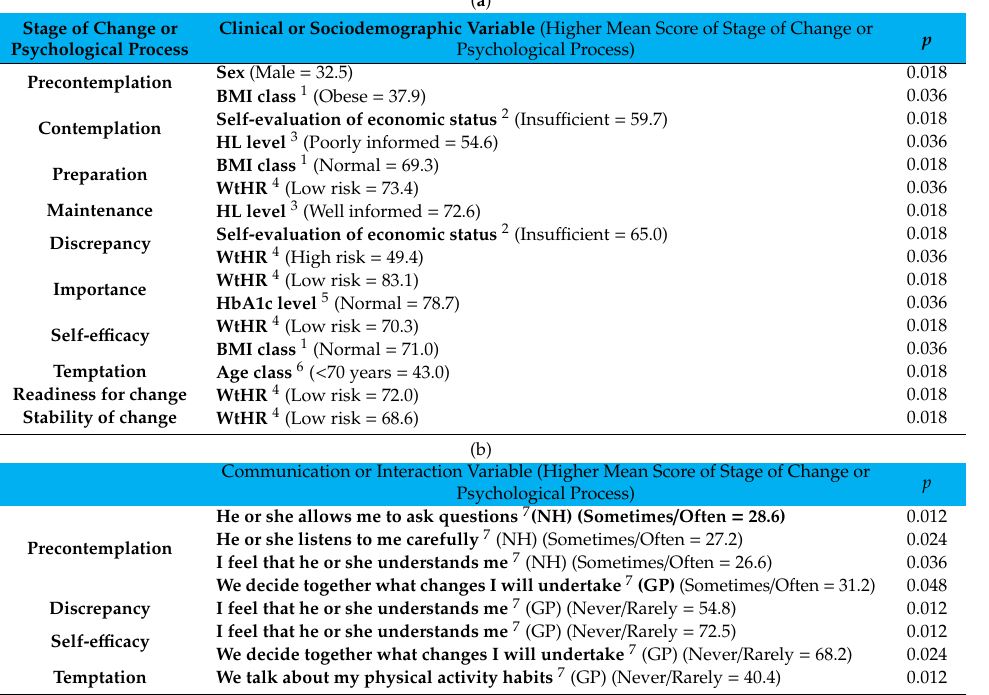
Table 4. ( a ) Stages of change or psychological processes and clinical or sociodemographic variables showing significantly di ff erent mean scores in the domain of physical activity habits. ( b ) Stages of change or psychological processes and communication or interaction variables showing significantly di ff erent mean scores in the domain of physical activity